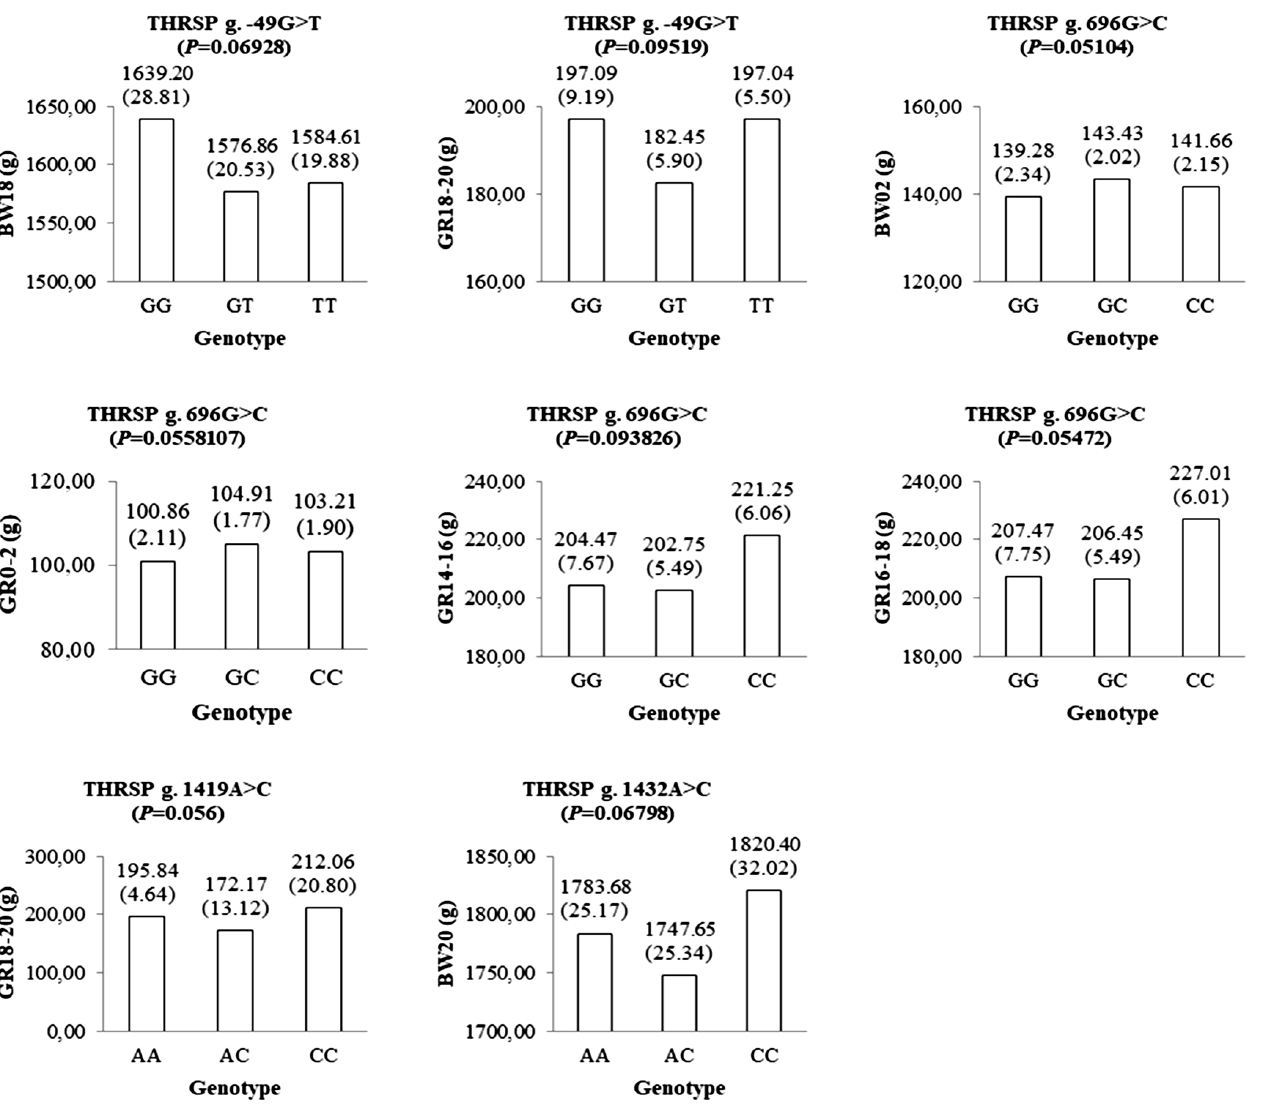
Figure 2. The genotypic means and standard errors of growth-related traits represent suggestive-significant associations between the genotypes of the THRSP gene and growth-related traits. p values were calculated using a mixed-effects model analysis. THRSP, thyroid hormone responsive spot 14 alpha